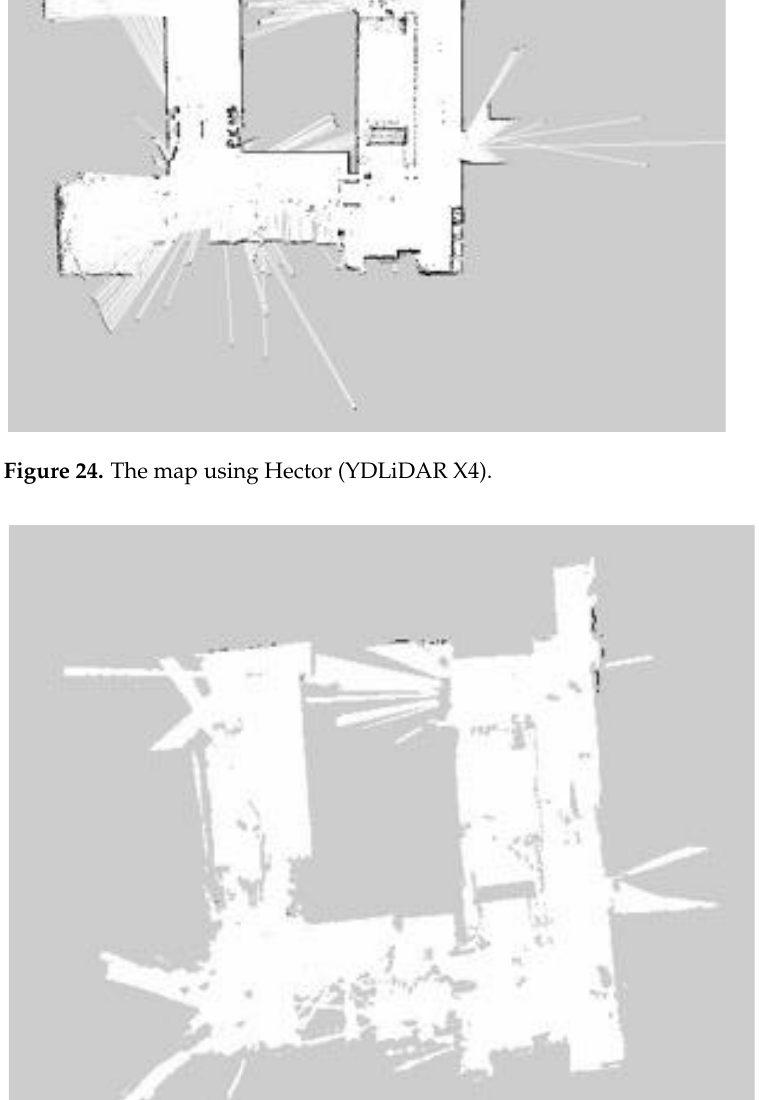
Figure 25. The map using Cartographer (YDLiDAR X4).